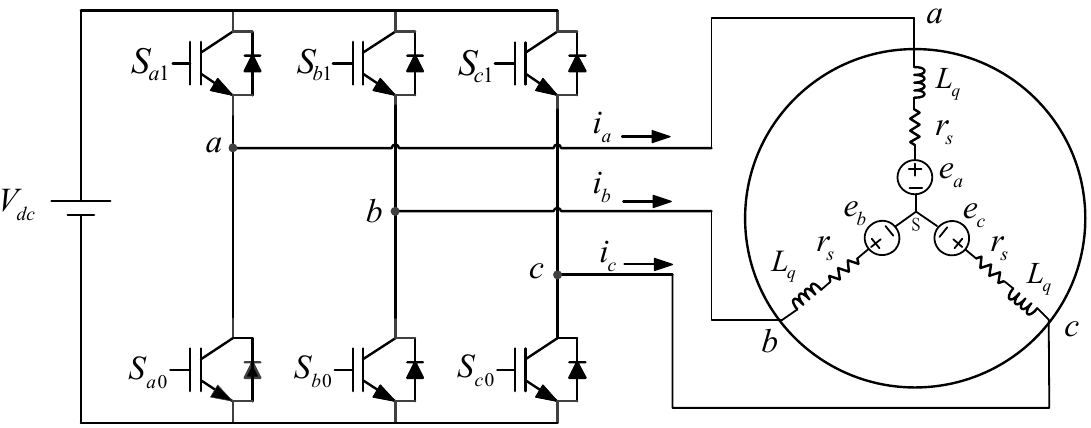
Figure 1. Six-switch three-phase inverter connected to a SynRM.